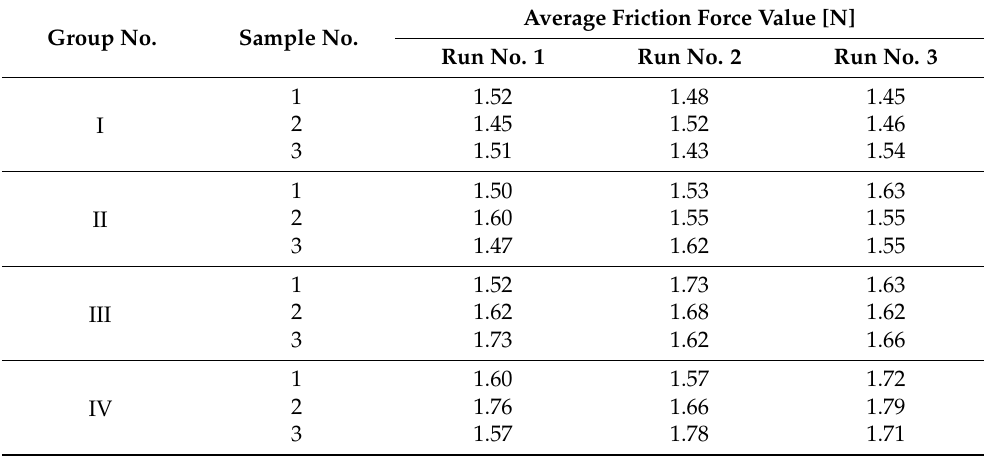
Table 4. The results of the average friction force in individual tests. Group No. Sample No.